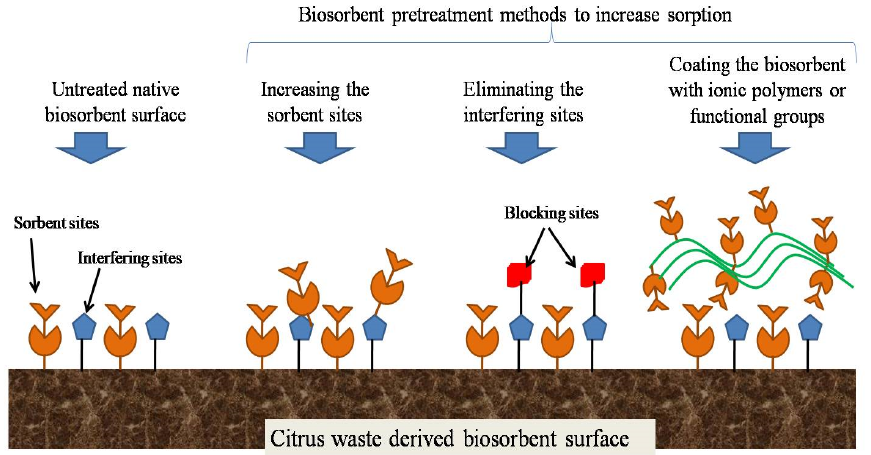
Figure 5. Basic principle of surface modification of citrus waste-derived bio-sorbent material by chemical pre-treatment for the removal and recovery of heavy/precious metals. Artwork created from the information provided in [68].